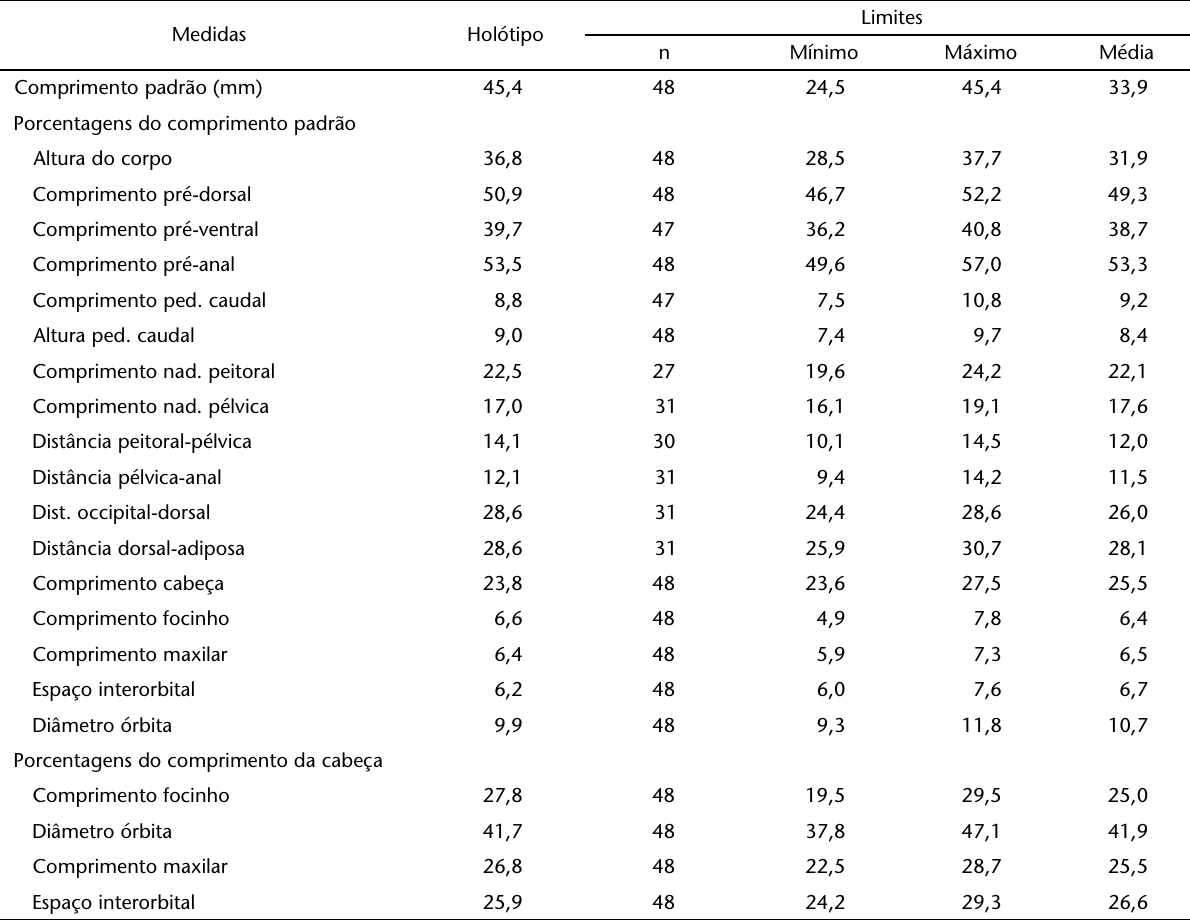
Tabela II. Medidas de P. maculoblongus sp. nov. , holótipo MBUCV-V-30230. (n) Número de exemplares, incluindo o